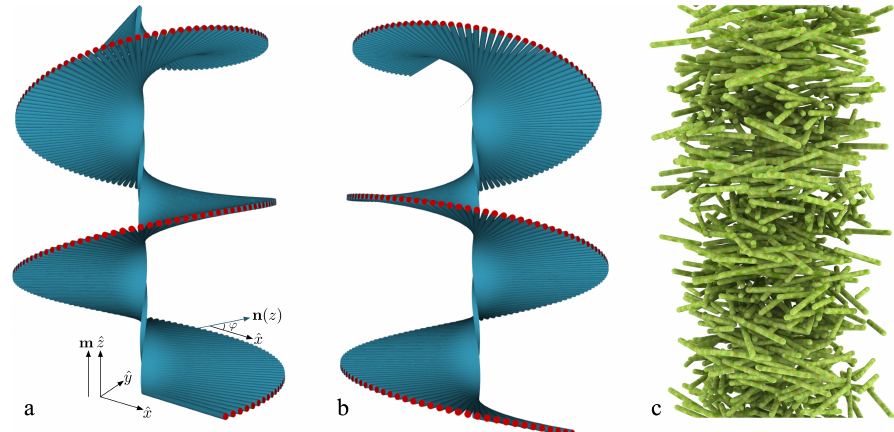
Figure 3. ( a , b ) Illustrations of the helix that is traced by the tip (red) of the director n (blue) as it continuously changes its orientation within the xy -plane when we move up the helix axis m , here considered along the ˆ z -axis, for the case of right-handed ( a ) and left-handed ( b ) helical director modulations. Note that these drawings do not show any CNC rods, only the variation through space of n . A representative ’snapshot’ of rod distributions, as influenced by the helical director modulation and the imperfect orientational order ( S ≈ 0.8) is instead shown in part ( c ). The corresponding director helix is left-handed, as in ( b ) and as in CNC